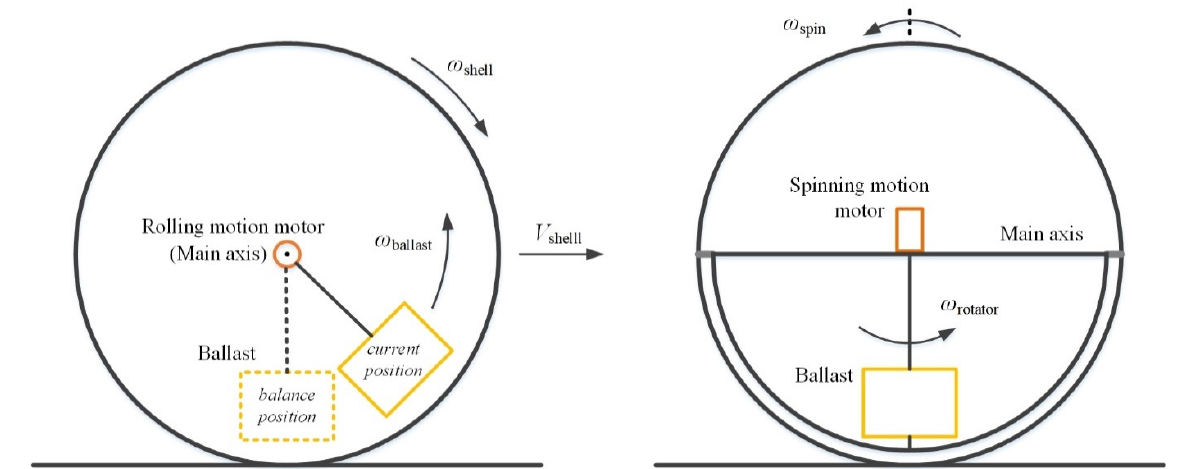
Figure 2. Schematic of rolling motion and spinning motion.